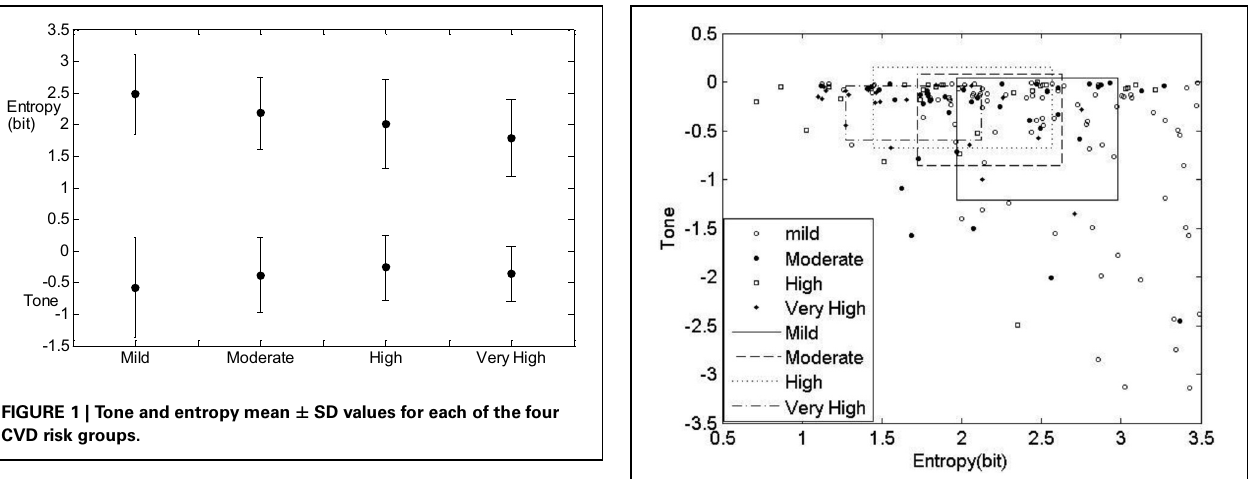
FIGURE 3 | Tone-Entropy plot of all subjects in four